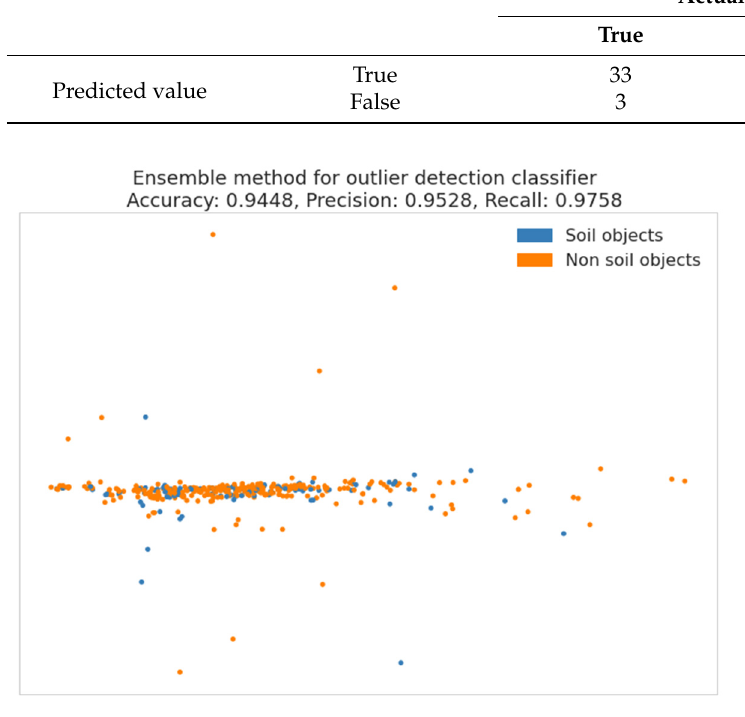
Figure 9. Ensemble method classifier for the outlier detection predictions. Dimension reduced with a principal components analysis (PC1 and PC2).